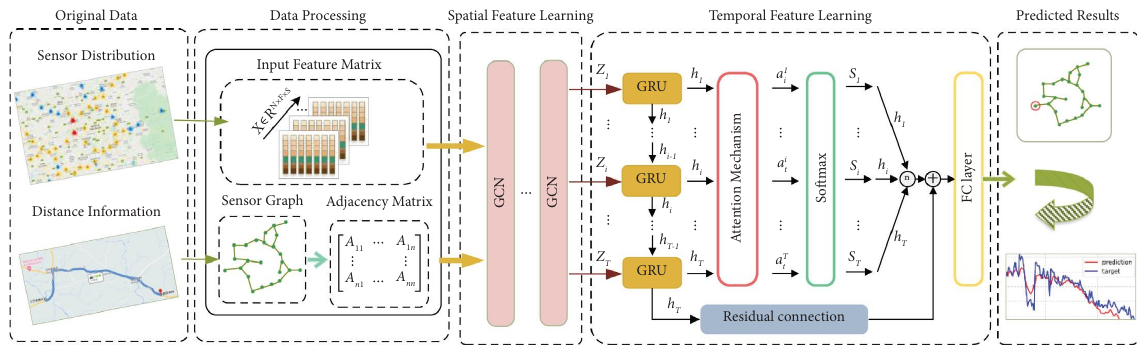
Figure 3: Te overall architecture of the AGRGCN